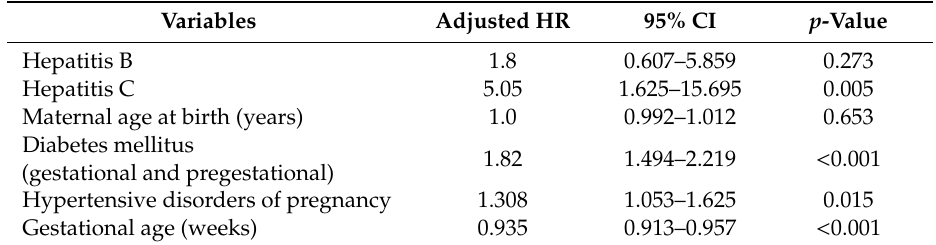
Table 3. Cox regression model estimation results: adjusted hazard ratios and respective